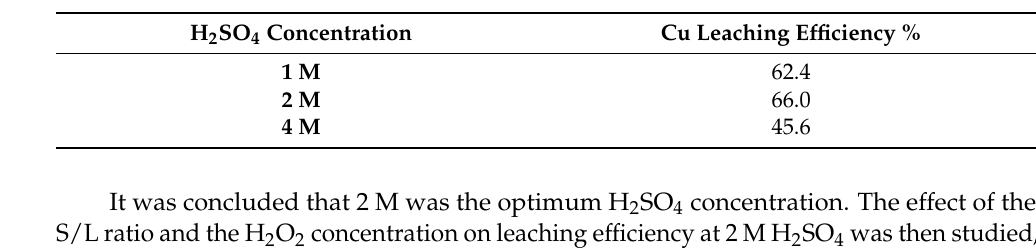
Table 2. Cu recovery after two-step leaching of the copper dust in 1 M, 2 M, and 4 M H 2 SO 4 in an